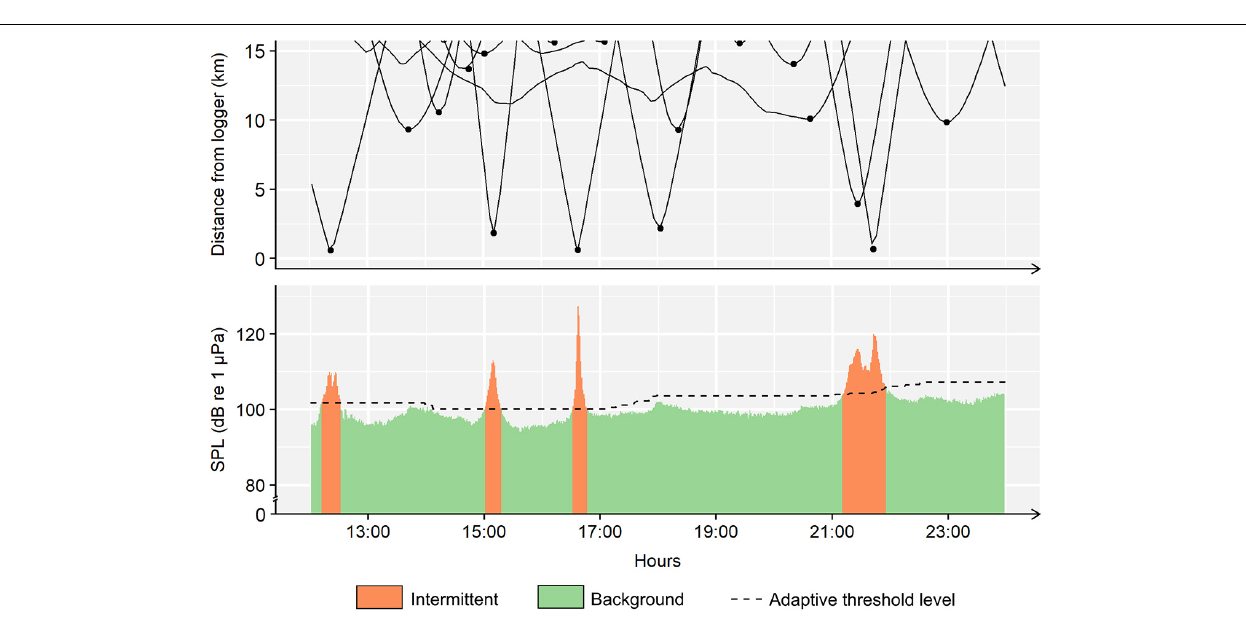
FIGURE 5 | An example of comparing data AIS and 10–10,000 Hz broadband SPL data (hydrophone 21 between 12:00 and 23:59 on January 17th, 2014). The lower diagram shows the identification of the intermittent and background components of the acoustic environment. The adaptive threshold level is illustrated as a dashed black line. The upper diagram shows the proximities of moving vessels with the computed CPA as black dots.